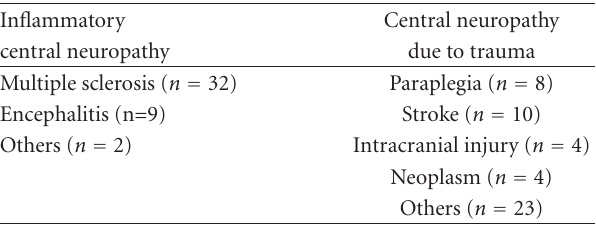
Table 1: Etiology of the diagnosed central neuropathic pain. Neuropathies within the patient cohort were grouped by an inflammatory origin ( n = 43) or a trauma of the central nervous system ( n = 49). Note that fibromyalgia patients ( n = 32) are not